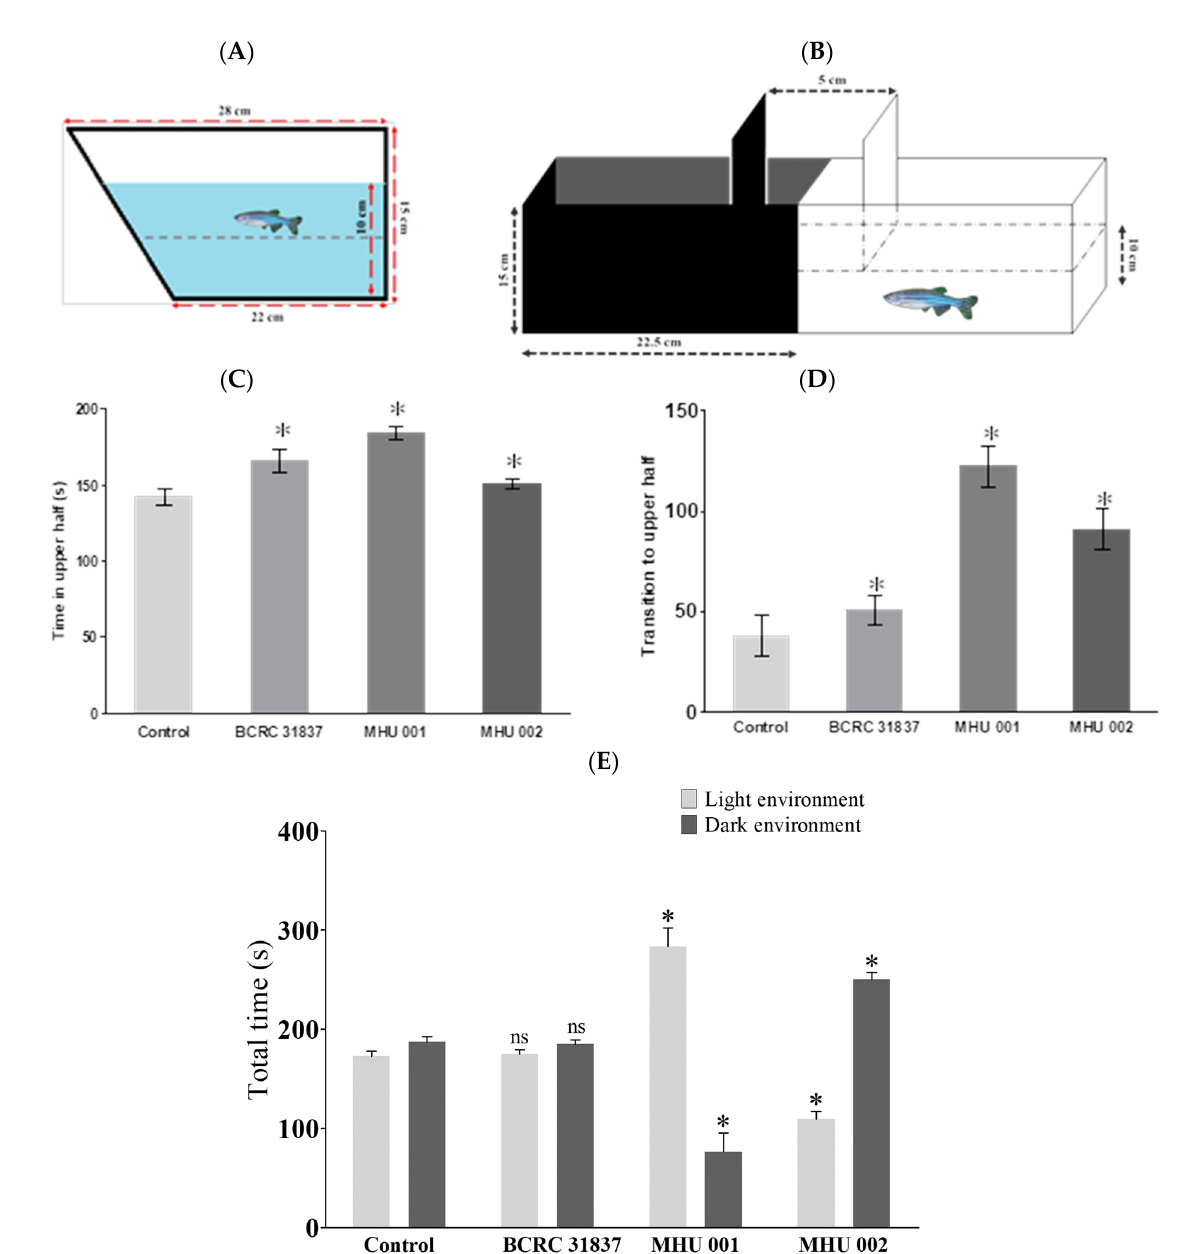
Figure 2. Novel tank diving test for behavioral testing in adult zebrafish. ( A ) Light-dark test tank test for behavioral testing in adult zebrafish ( B ). Novel tank diving test shows the time in seconds that the four groups of adult zebrafish spent in upper part of the novel tank; those in the upper part engaged less anxiously in exploratory behavior. Control groups were fed normal meals, and the experimental groups were fed tempeh fermented with different strains of R. oryzae BCRC 31837, MHU 001, and MHU 002. ( C ) Time in the upper half (s); ( D ) transition to the upper half (s), and light–dark tank test ( E ). The asterisks indicate statistically significant differences between the control and the tempeh groups. Bars, means of triplicates ± S.D. (*) p < 0.001, (ns) p > 0.05, as compared with the relative control group by one-way ANOVA ( C , D ) and two-way ANOVA (E), respectively; ns indicates non-significant differences.